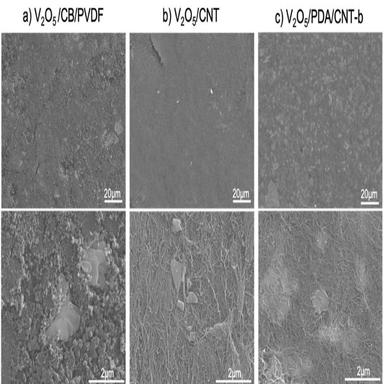
SEM images of electrodes: a) V2O5/CB/PVDF, b) V2O5/CNT and c) V2O5/PDA/CNT-b electrodes.